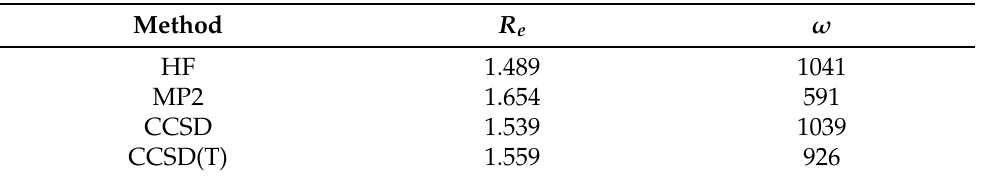
Table 2. Equilibrium Fe-C distance ( R e , in Å) and harmonic vibrational Fe-C stretching frequencies (in cm − 1 ) computed at systematically more accurate levels of